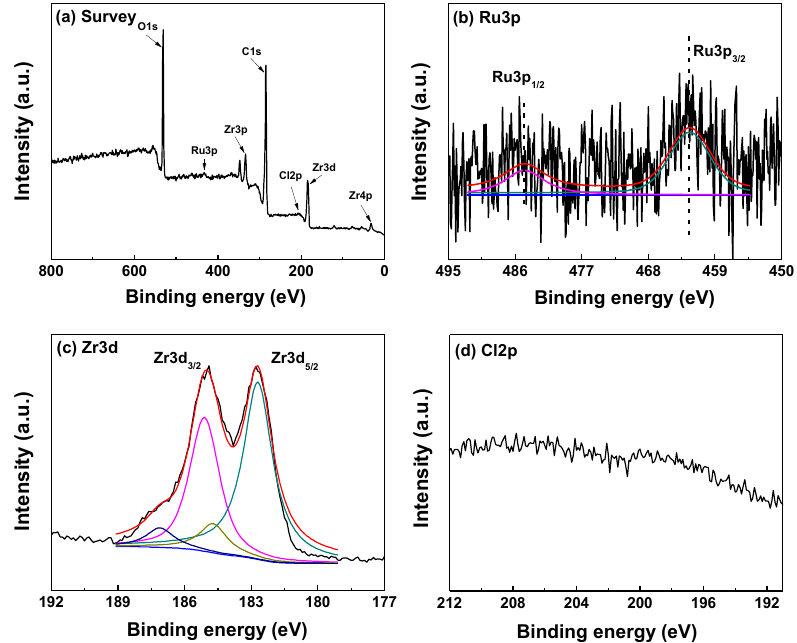
Figure 5. The X-ray photoelectron spectroscopy XPS spectra of ( a ) survey, ( b ) Ru3p, ( c ) Zr3d, and ( d ) Cl2p over Ru@UiO-66 and UiO-66.